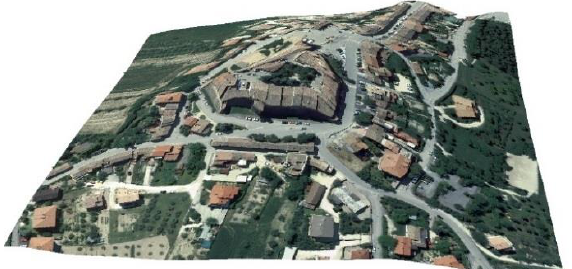
Figure 7. LOD0, 2.5D Digital Terrain Model over which an aerial orthophoto is draped